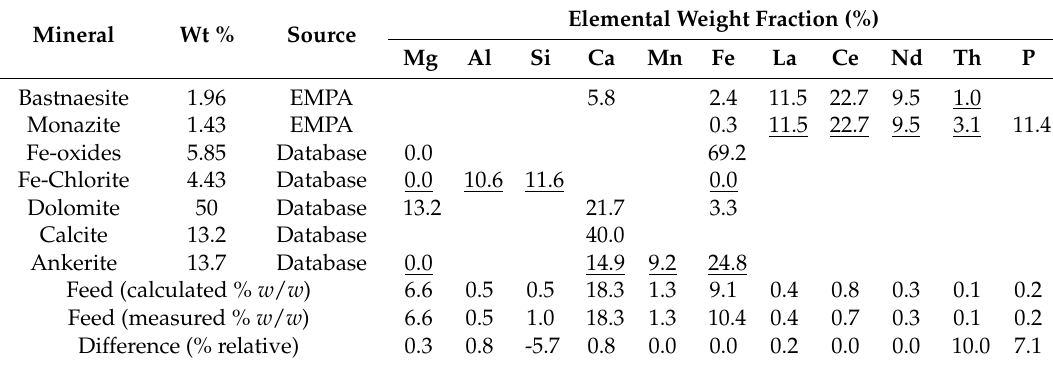
Table 3. Mineral compositions and feed composition. (EMPA, Electron Microprobe Analysis).